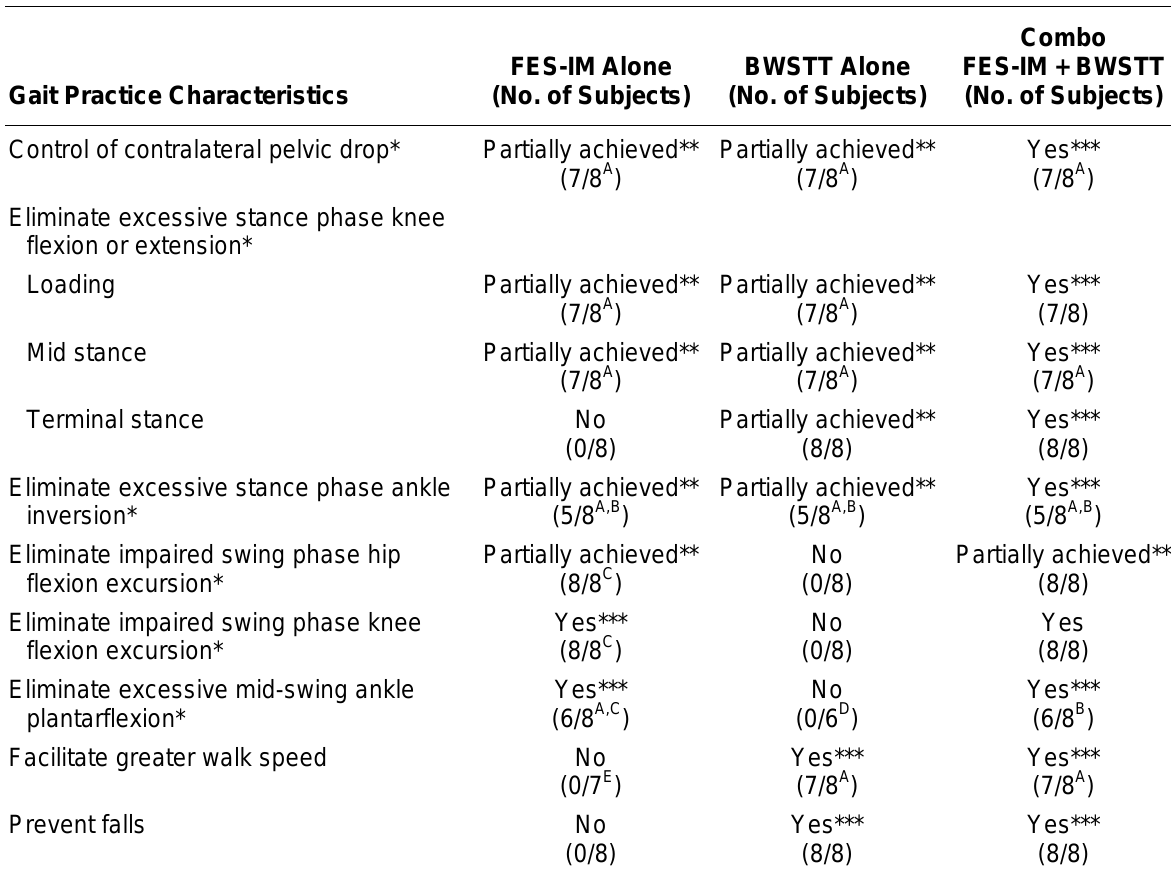
Capability of Three Different Modalities to Provide Gait Practice Characteristics